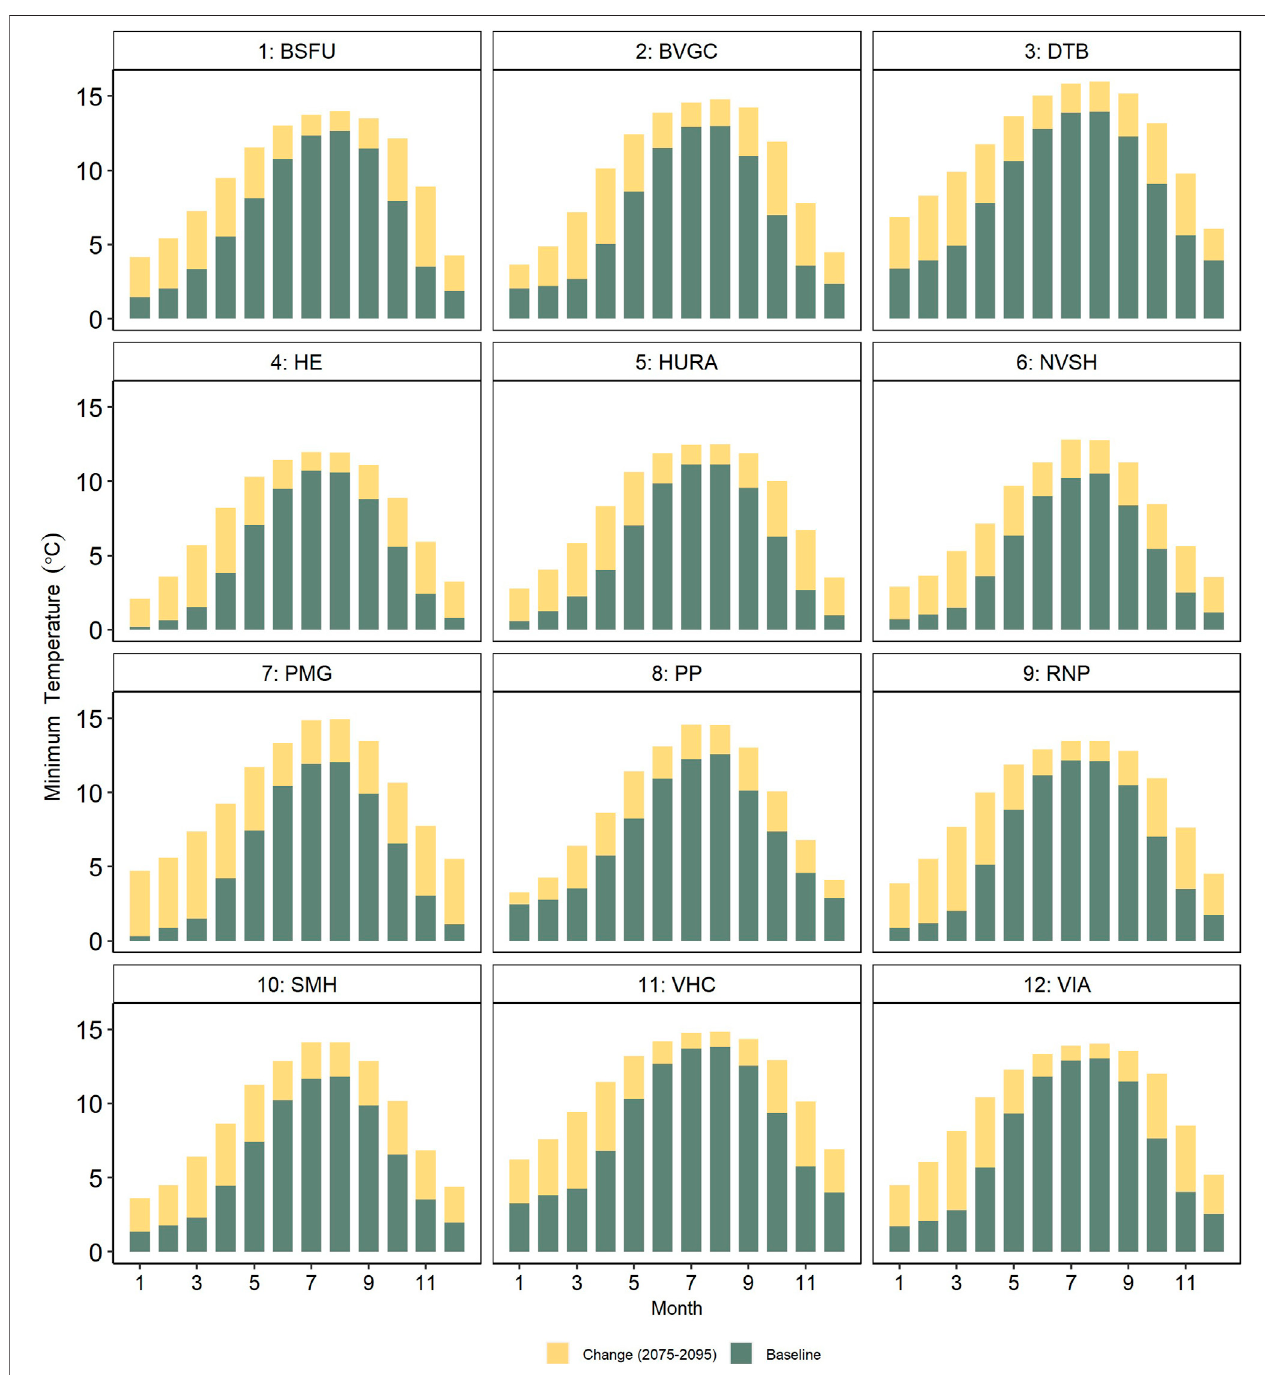
FIGURE 11 | Monthly baseline and projected changes of 2075 – 2095 for minimum temperature.